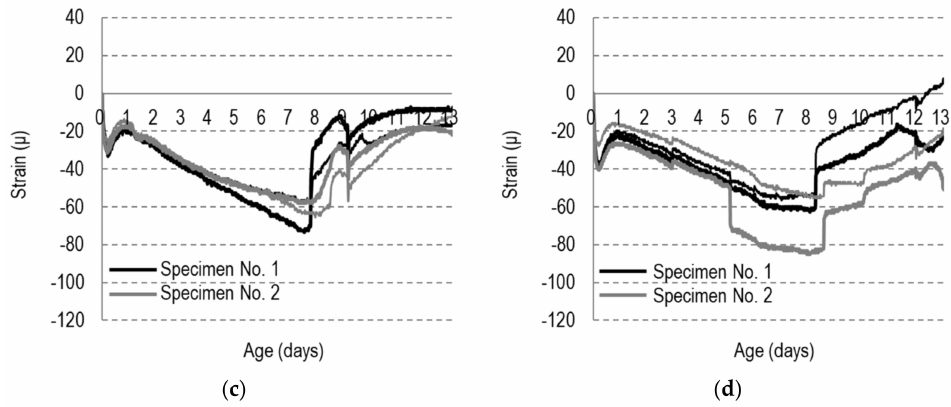
Figure 7. Strain history of inner ring (W160 mixtures): ( a ) D10, ( b ) D20, ( c ) D40, and ( d ) D60. The average net time to cracking is 8.45 days for the W170 mixtures and 8.95 days for the W160 mixtures, indicating that the W160 mixtures have the highest crack resistance. In general, it is known that a concrete mixture that has a low water content has lower risks of drying shrinkage and cracking. The D10, D20, D40, and D60 mixtures yielded average net times to cracking of 8.65, 9.35, 8.35, and 8.45 days, respectively, indicating that the D20 mixture had the highest crack resistance.